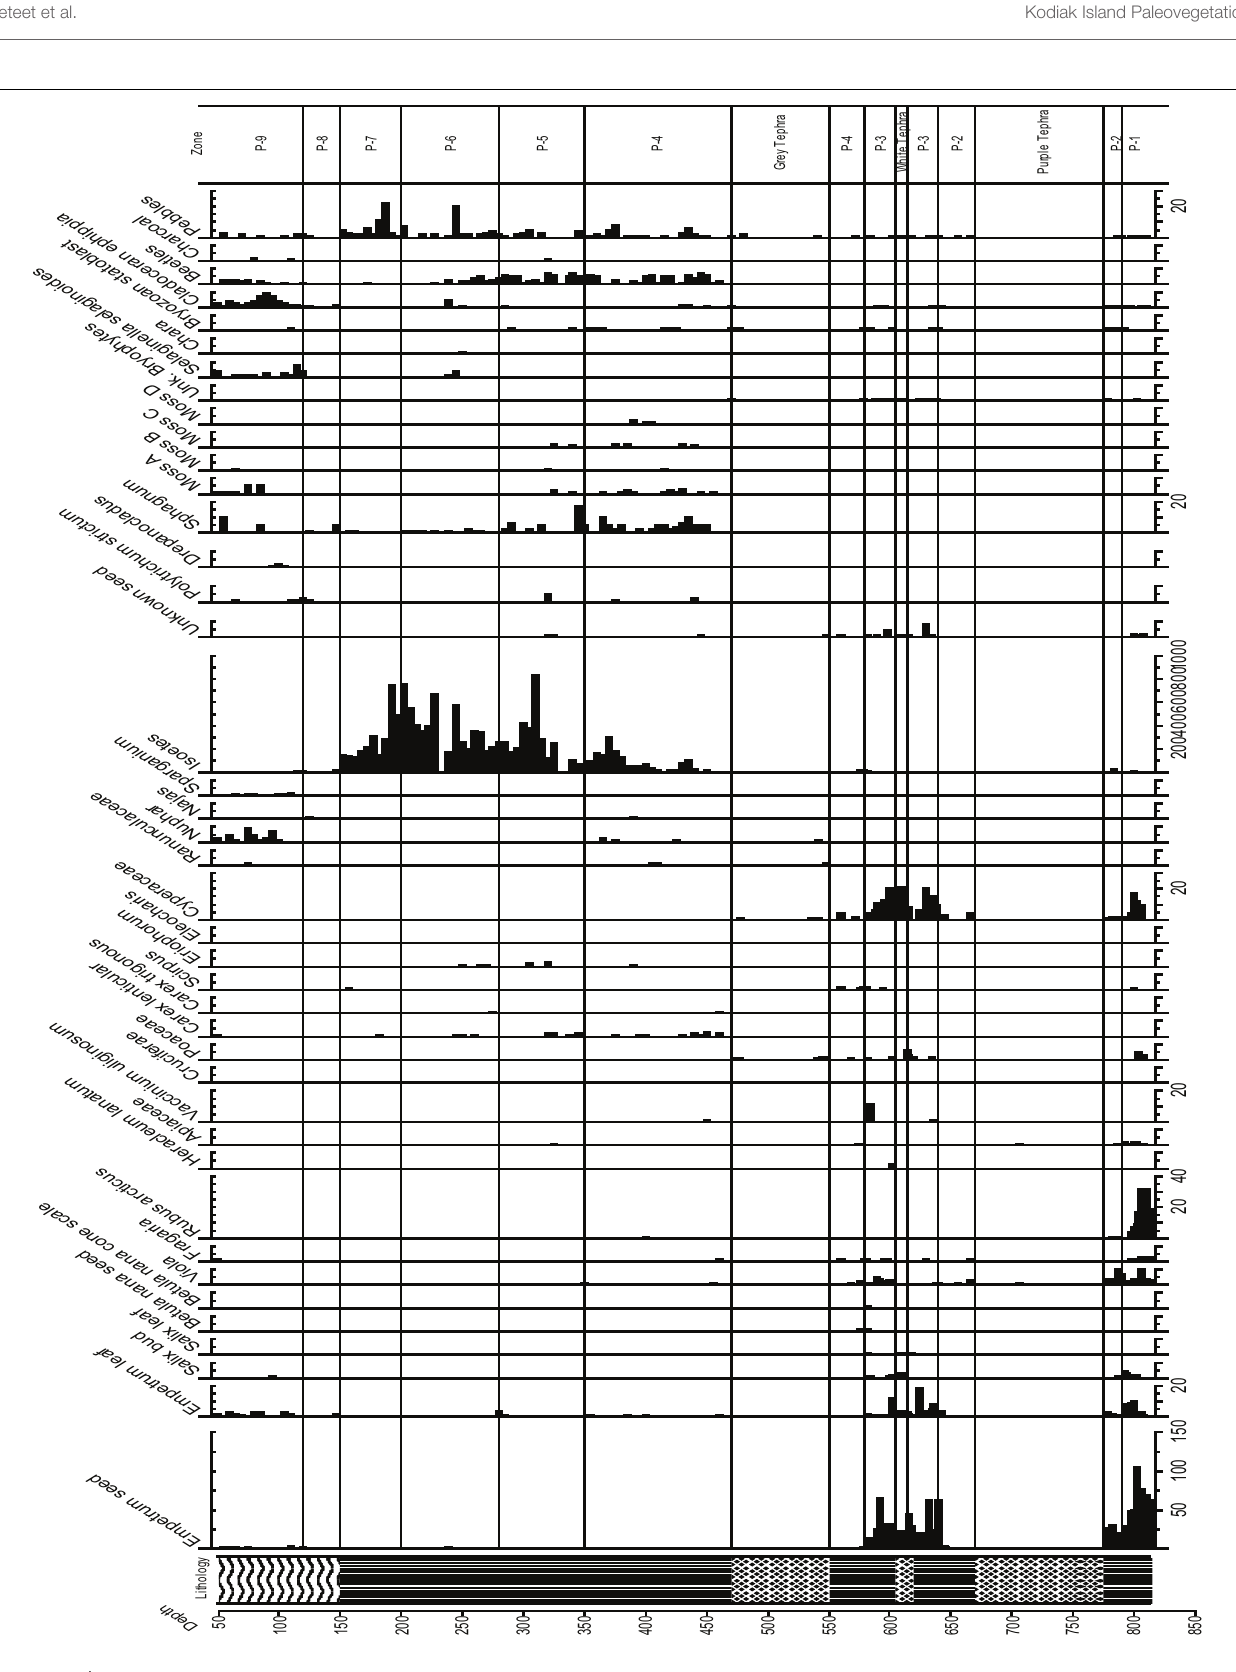
Frontiers in Earth Science |